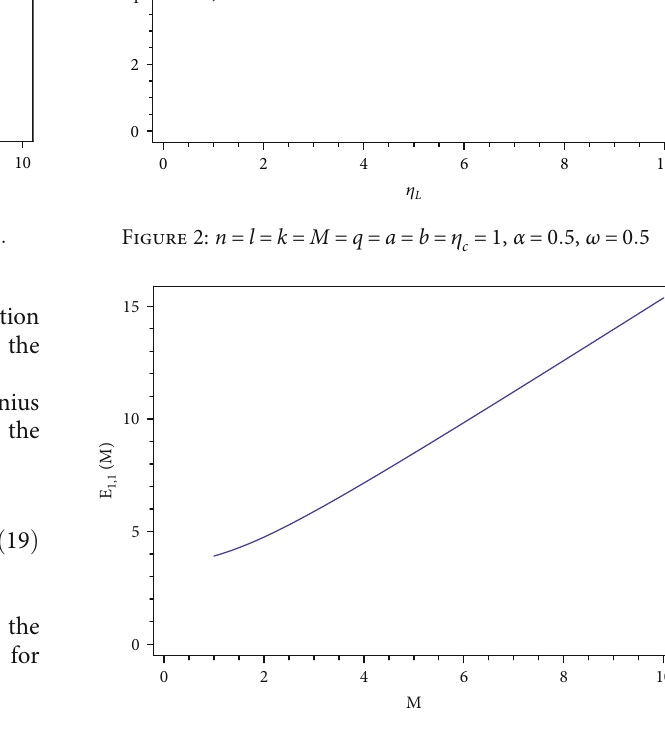
= η = 1 , α = 0 : 5 , ω = 0 : c L